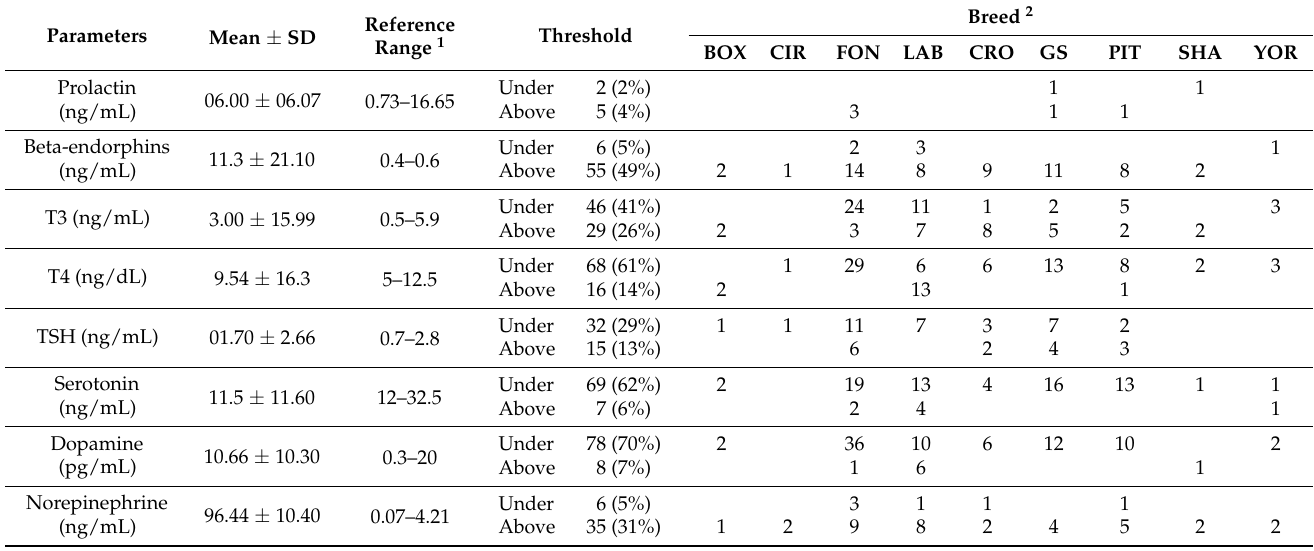
Table 1. Observed mean values for serum and plasma parameters, together with the reference ranges, obtained from investigated dogs.